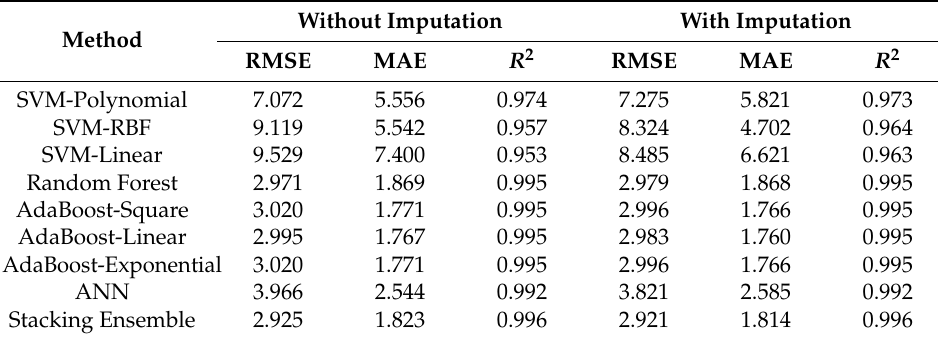
Table 10. Results of ML Algorithms for Fengshan F1-AQI Prediction.